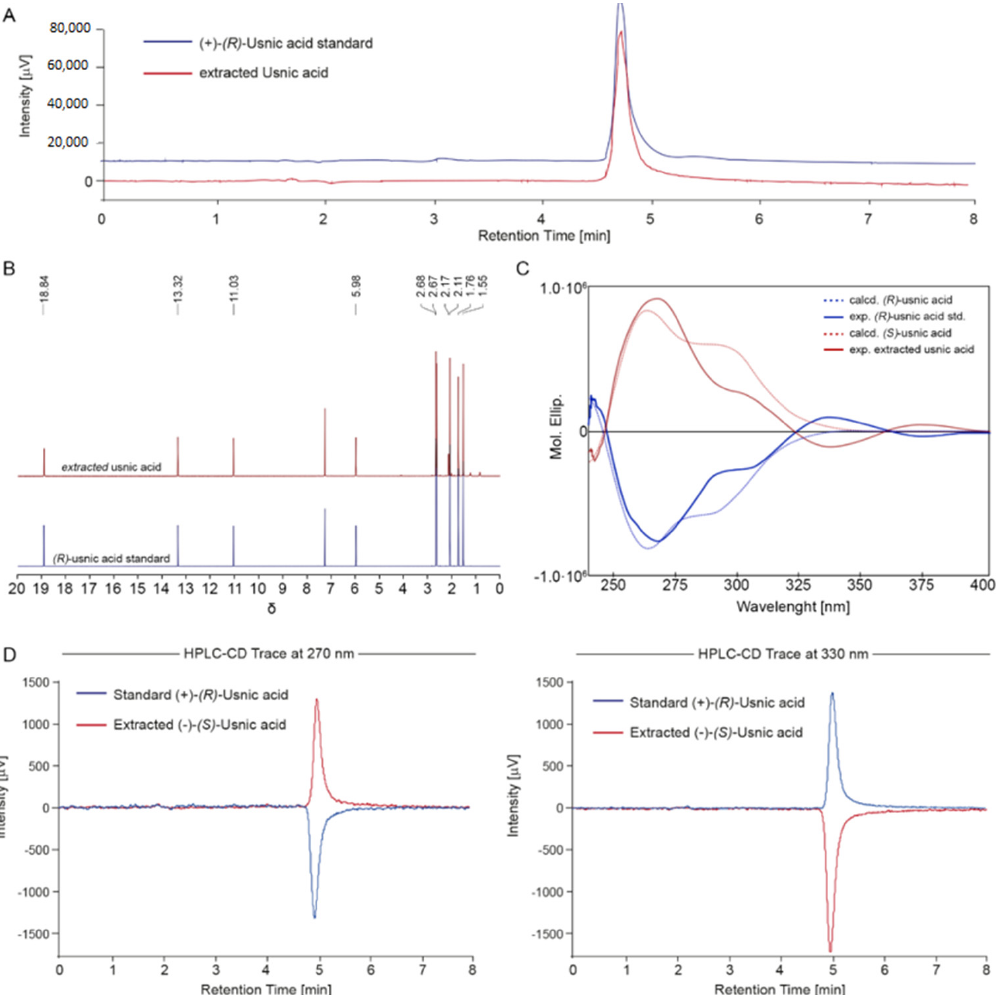
Figure 6. Superimposition of the ( A ) HPLC-UV chromatogram, ( B ) 1 H NMR spectra, ( C ) electronic circular dichroism (ECD) spectra in chloroform and ( D ) HPLC-CD traces acquired at 270 and 330 nm of extracted (S)-UA (in red) and (R)-UA standard.